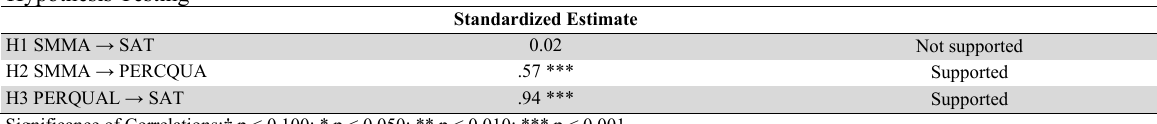
Hypothesis Testing